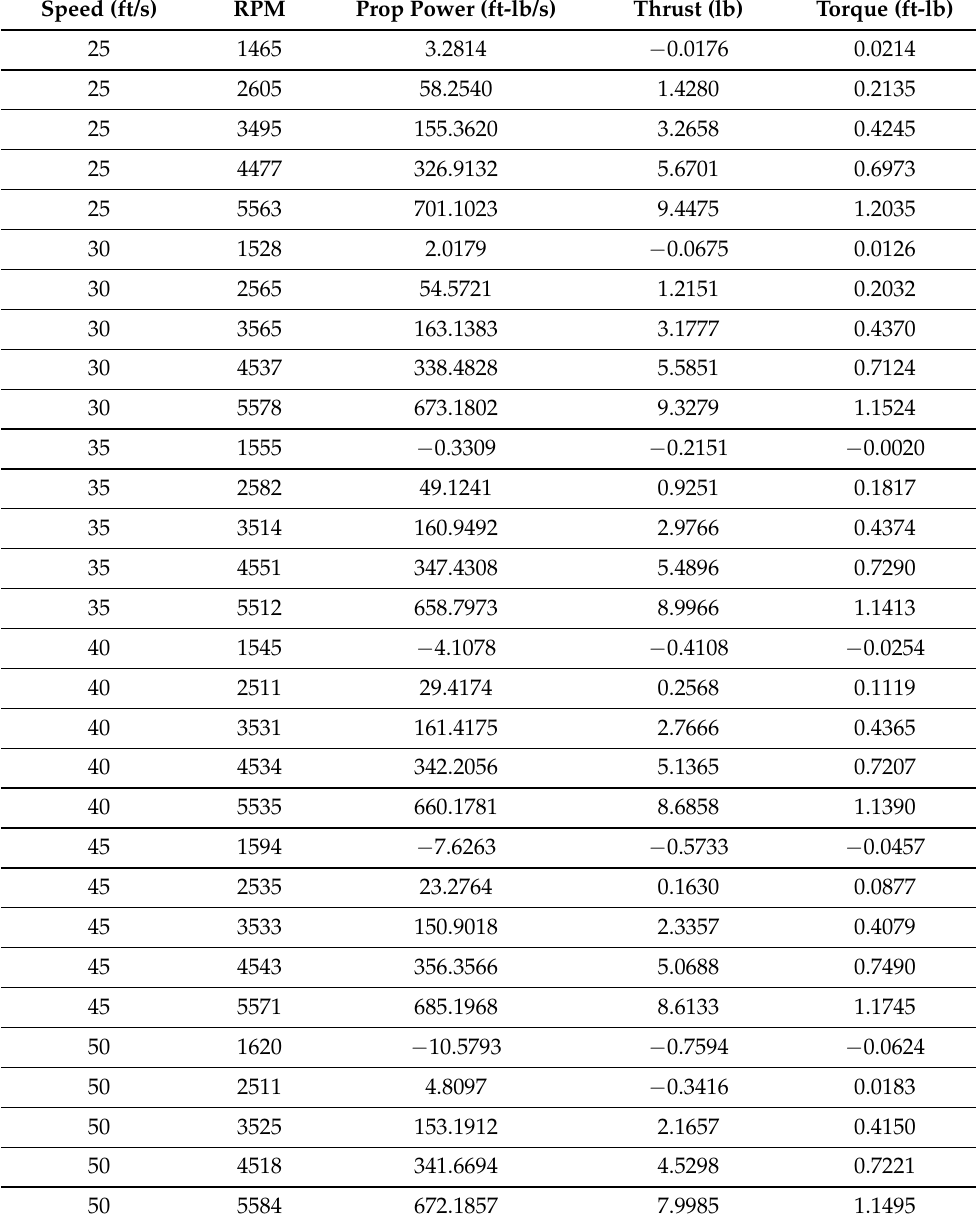
Table A12. APC 18 × 12 propeller wind tunnel raw